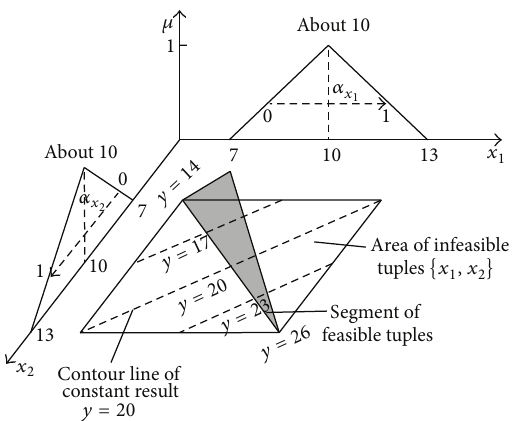
The right border of the 2D representation, the border of maximal 𝑦 values, is obtained for maximal values of RDM = 𝛼 = 1. variables 𝛼 𝑥 𝑥 2 1